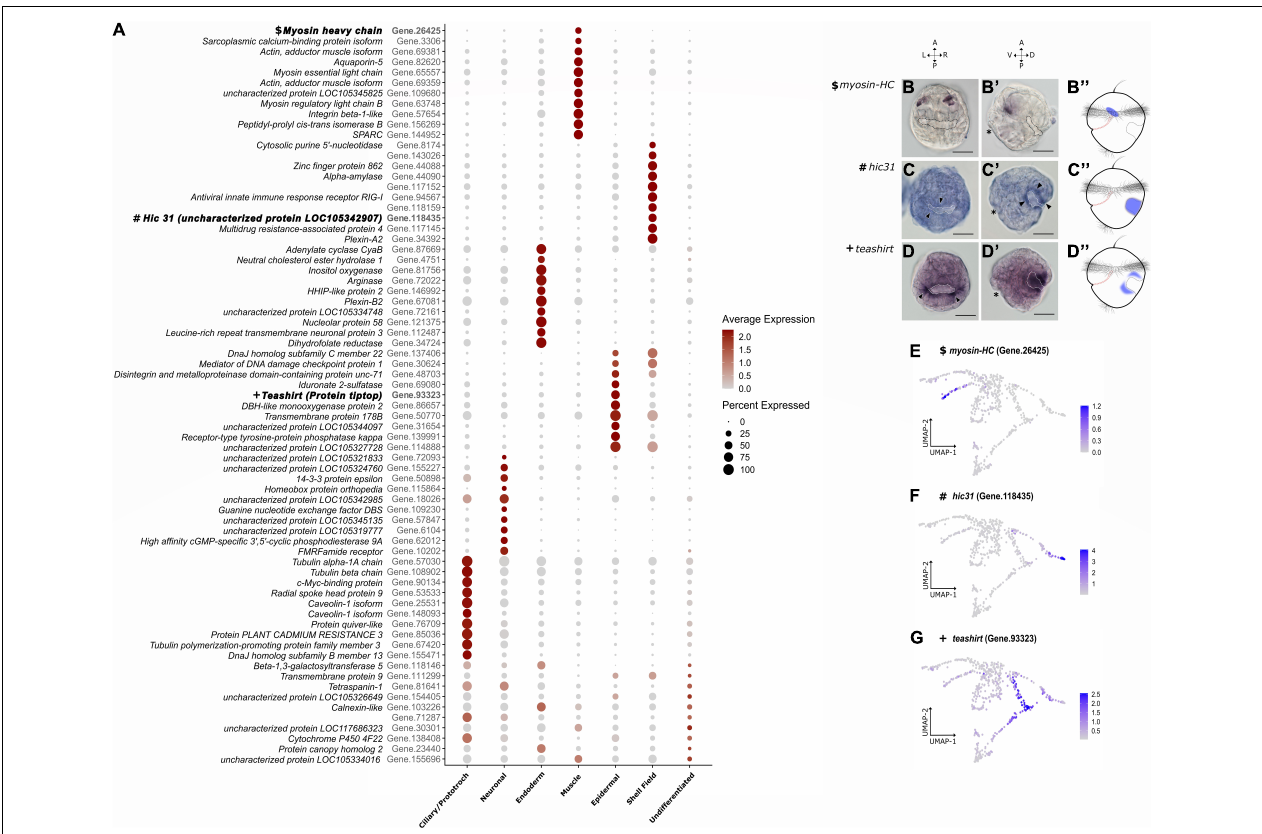
FIGURE 3 | Mapping cell state markers on the trochophore larva. (A) Top 10 highly expressed genes per cluster. On the left side of each gene is the putative ortholog match from Crassostrea gigas . Color intensity represents the average gene expression while circle size is the percentage of cells expressing a certain gene. In bold are the IDs of the genes used for cluster validation through in situ hybridization in (B–D) . (B–D”) Expression domains of randomly sampled marker genes from a dorsal (B–D) and a lateral point of view (B’–D’) . (B–B”) Mhc expression located in cells from the anterior region between the developing digestive tract and the shell field. Dotted lines highlight the secreted shell field. (C–C”) Hic31 expression located in cells belonging to the outer margin of the shell field (arrowheads). (D–D”) Tsh expression is found in the epidermal cells limiting the outline of the shell field. Asterisk indicates the mouth opening on the left side. Anterior (A), posterior (P), ventral (V), dorsal (D), left (L), and right (R). Scale bars are 20 µ m. (E–G) Feature plots of each respective gene used for in situ hybridization and after running the gene imputation algorithm with